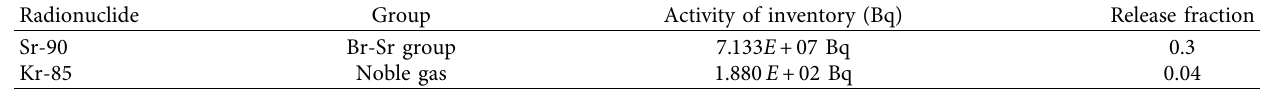
Table 2: Some selected radionuclide inventory in the HEU core at reactor shutdown.